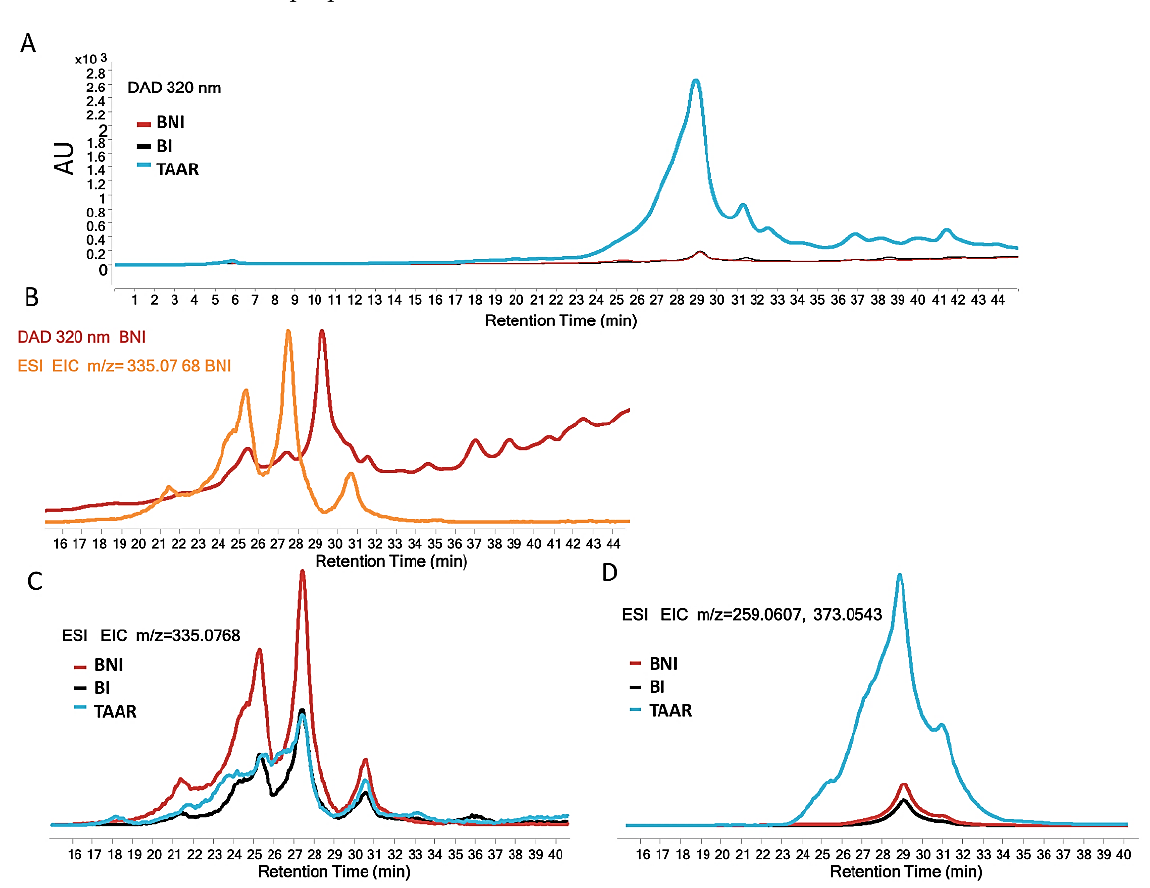
Figure 3. LC-DAD-MS analysis. LC-DAD-MS analysis of BI, BNI, and TAAT methanolic extracts of the root of the date palm, where ( A ) corresponds to DAD chromatograms at 320 nm, ( B ) overlap of DAD chromatogram and extracted ion chromatogram (EIC) of the ion 335.0768 targeting all position isomers of caffeoyl-shikimic acid in BNI, ( C ) shows the relative abundance of all position isomers of caffeoyl-shikimic acid and ( D ) shows the relative abundance of 3,3′,4,5,5′ -pentahydroxy-trans-stil- bene. 3.6. The Stilbene Inhibition of FoA Mycelium Growth Is Associated with Date Palm Resistance to FoA The effect of the five hydroxy-stilbenoid derivatives was evaluated at three different concentrations (50, 75, and 100 µ g/mL) on three strains in vitro FoA mycelium growth. As shown in Figure 4, for all tested compounds, as the concentration increased, mycelium growth inhibition increased as well. For instance, PHS at 50, 75, and 100 µ g/mL inhibits FoA mycelium growth by 43, 64, and 90%, respectively, with an IC 50 value of 56.8 µ g/mL. However, according to the tested compound, IC 50 values varied from <50.0 to 60.7 µ g/mL (for resveratrol, oxyresveratrol, piceatannol, PHS, and isorthapontigenin, respectively), suggesting that hydroxyl and/or methoxy-substitutions of the B-ring of the basic chemical structure of stilbene is able to induce inhibition of FoA mycelium